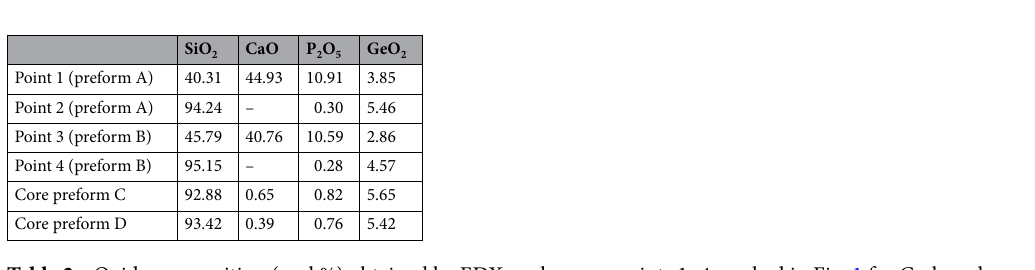
Table 2. Oxide composition (mol.%) obtained by EDX analyses on points 1–4 marked in Fig. 1 for Ca-based nanoparticle doped